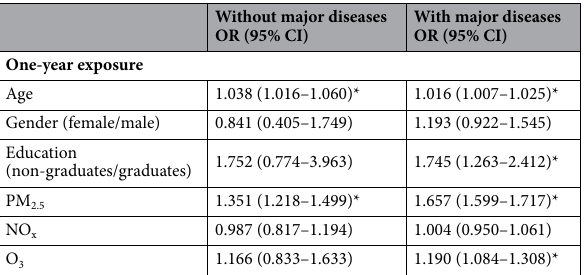
Table 3. Comparison of the odds ratio of PM 2.5 , ozone, and NOx on insomnia with (N = 4039) and without (N = 1069) major chronic diseases estimated by stratified analysis. *Statistically significant: p <